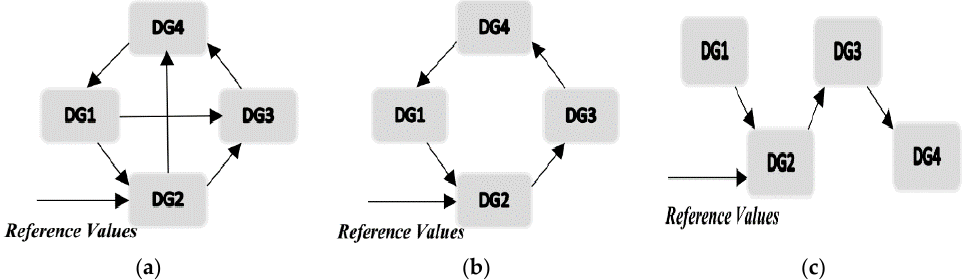
Figure 15. Various communication topologies for the test MG system: ( a ) mesh ( b ) ring and ( c ) line for case 5. Table 3. Convergence time for various communication topologies.